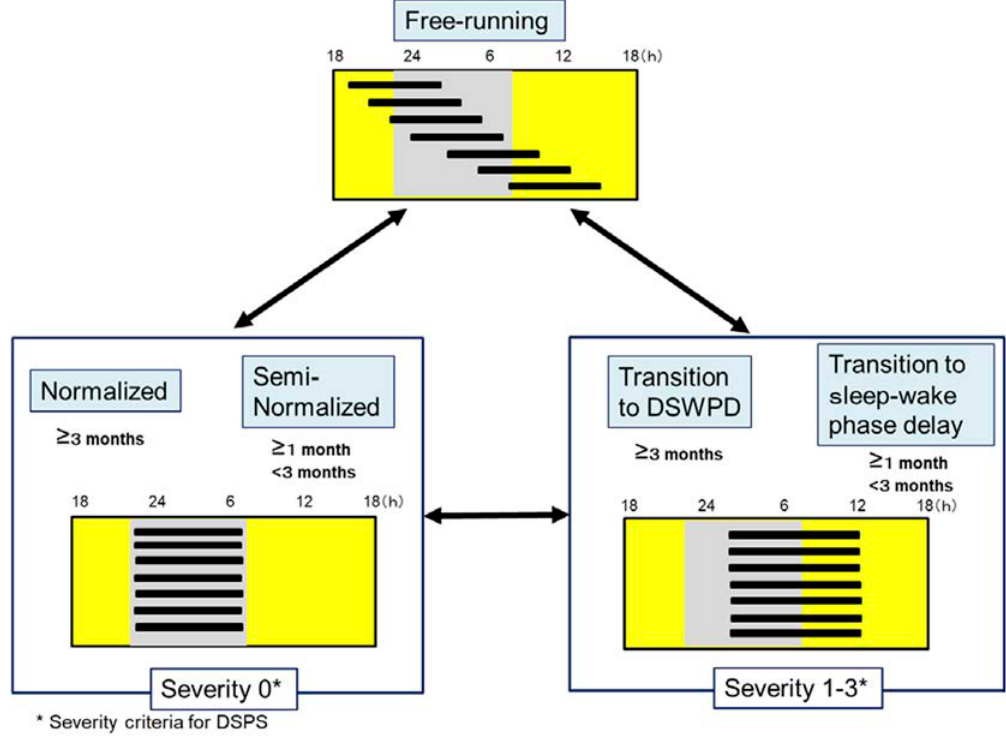
Figure 1 Schema of the definitions of clinical states in N24SWD. ⋆ Severity criteria for DSPS. 10 The yellow boxes are the schematized sleep diary of each clinical state, where the thick black line represents sleep phase and the gray shaded area represents desirable time range for sleep. Bidirectional transition (double-headed arrows) among these clinical states can occur during a course